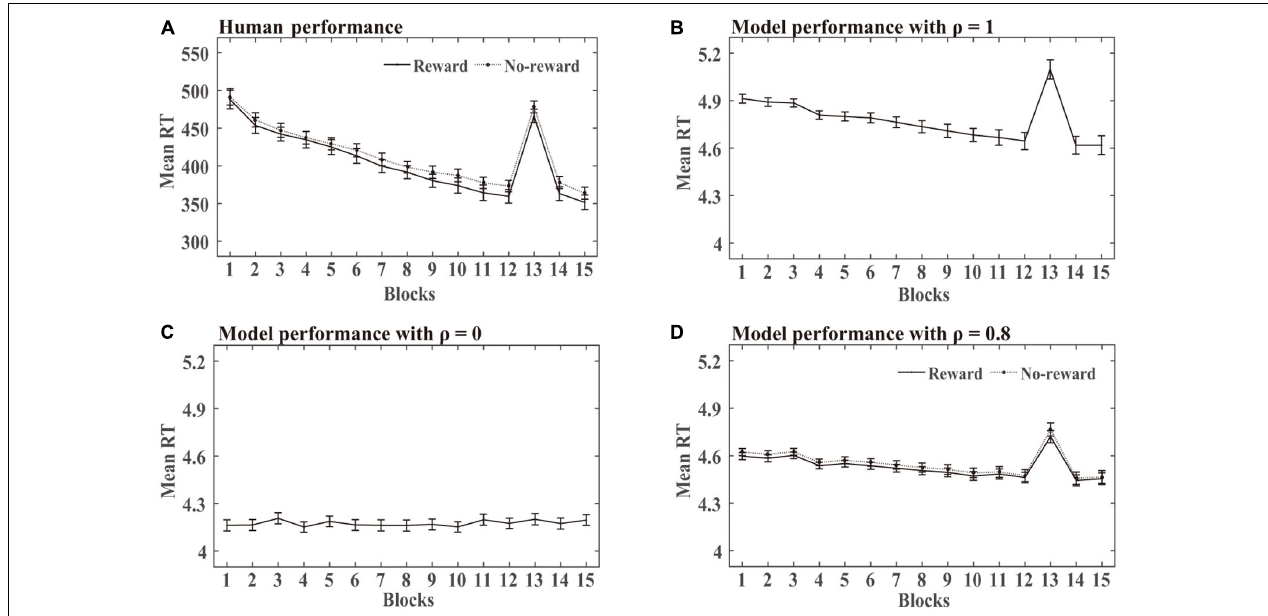
FIGURE 3 | Human and model performance in the SRT task in Simulation 1. (A) Mean RTs for human participants in the SRT task. (B–D) Mean RTs for models with different ρ values in the SRT task.